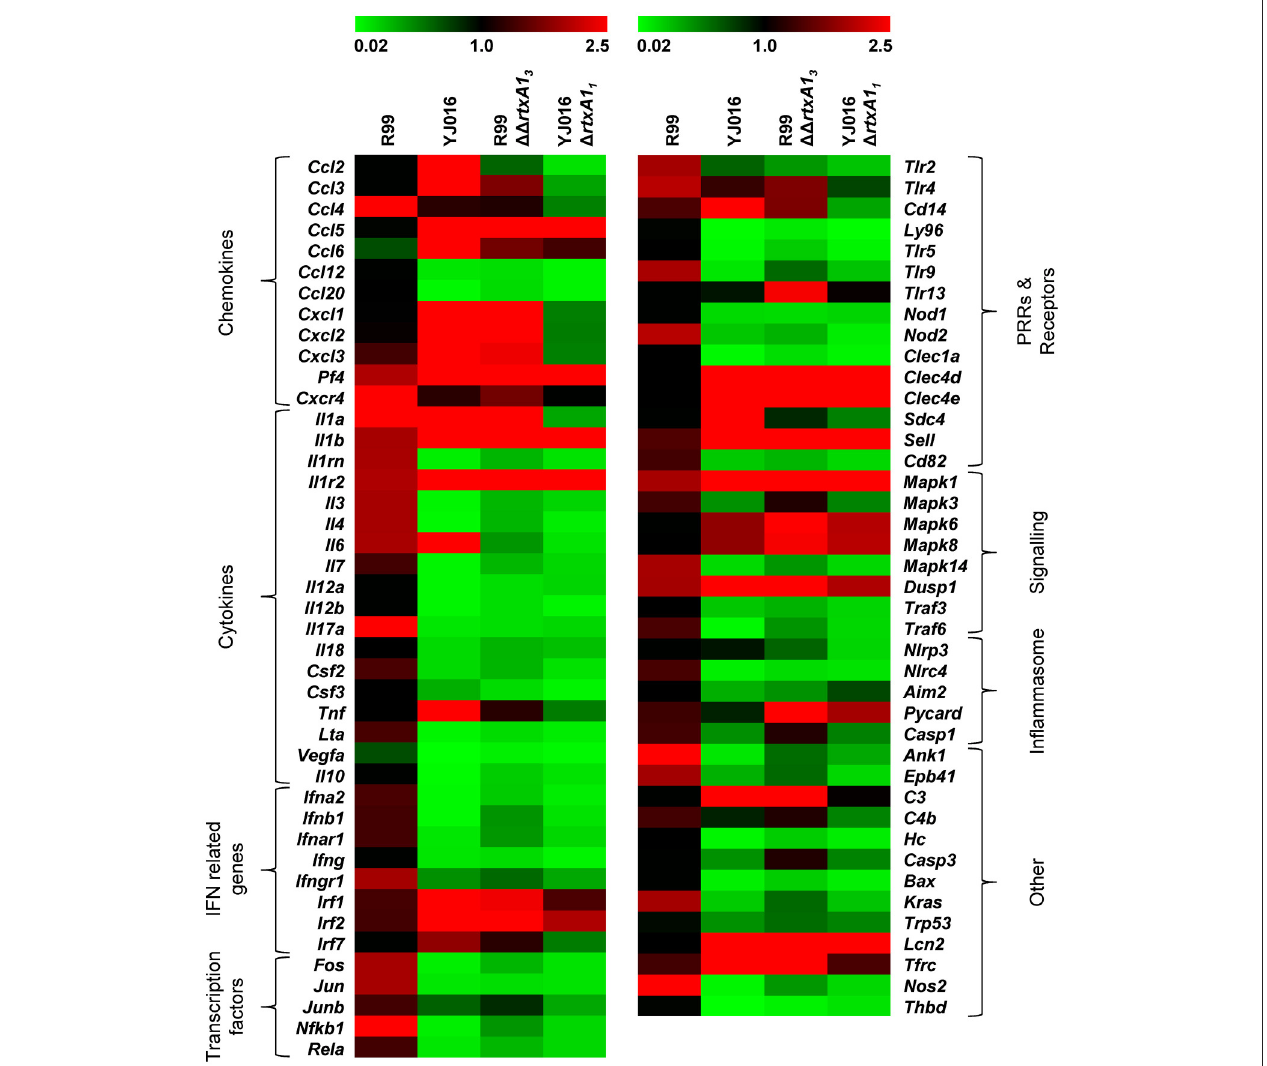
FIGURE 7 | Heat Map. Heat map representing color-coded expression levels of the 84 genes analyzed in infected mice for 4 h with strains Bt2-SerE R99 and Bt1-RtxA1 1 YJ016, and their derivative RtxA1 mutants. Genes are arranged in functional categories.